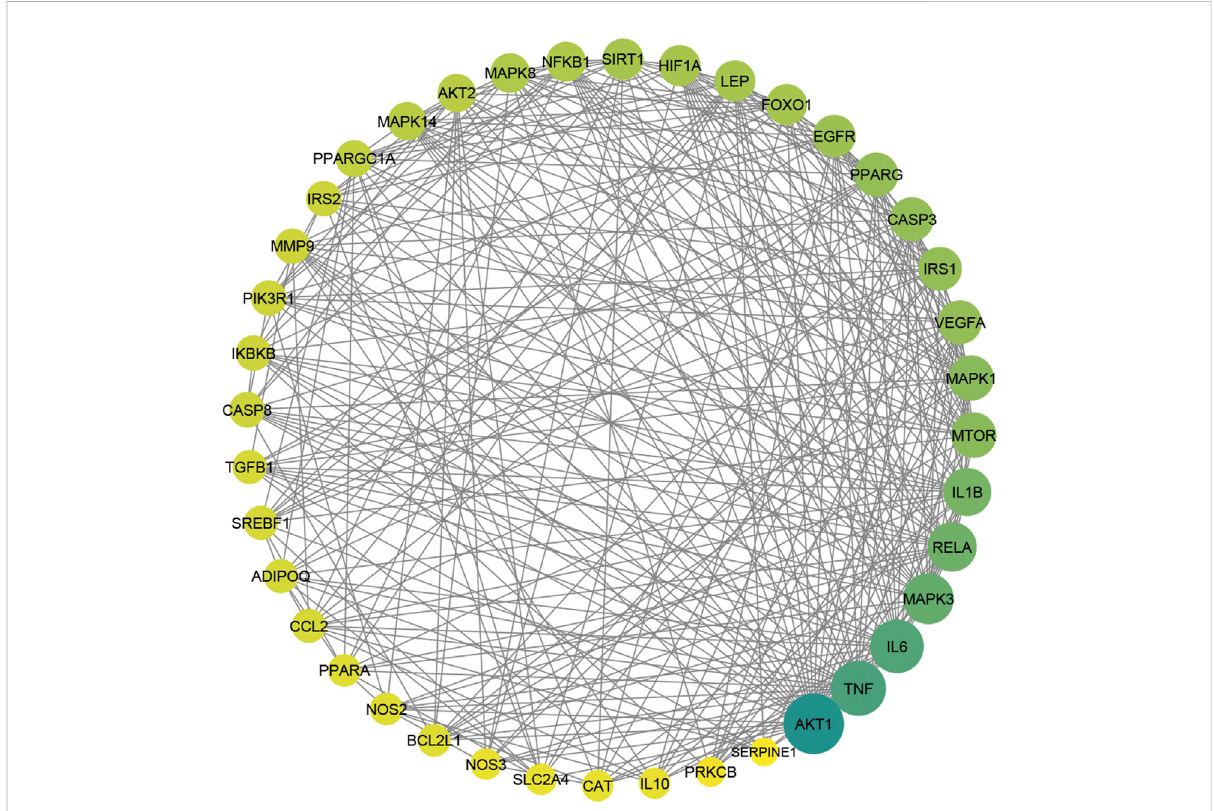
FIGURE 6 ThePPIof40majorhubsorcorekeytargetsofMAinT2DMtreatmentisorderedbycolorandsizebasedondegree,frombigandgreentosmall and yellow, after the exclusion of the core targets affected by fewer than seven compounds. Adjusting the size of the images and resolution was carried out using